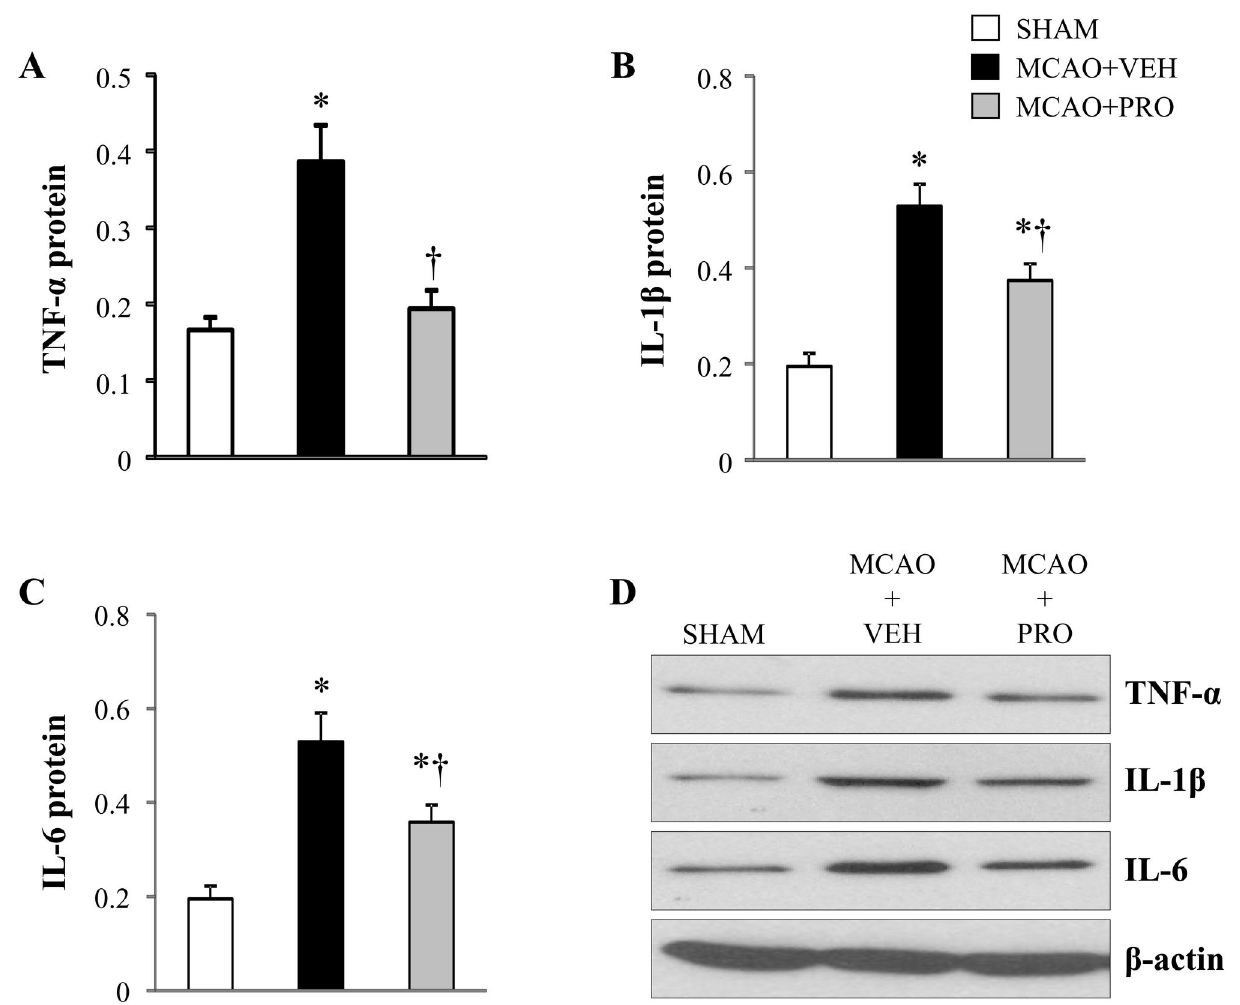
Figure 5. Protein levels for proinflammatory cytokines TNF-α (A), IL-1β (B) and IL-6 (C) in the peri-infarct cortical tissue 24 h after MCAO in rats treated with VEH or PRO. SHAM rats without treatment were used as control. Representative Western blots are shown in figure D. Values are expressed as mean ± SEM (n= 8 for each group) and corrected by β-actin. * P < 0.05 vs. SHAM, † P < 0.05 MCAO+PRO vs.